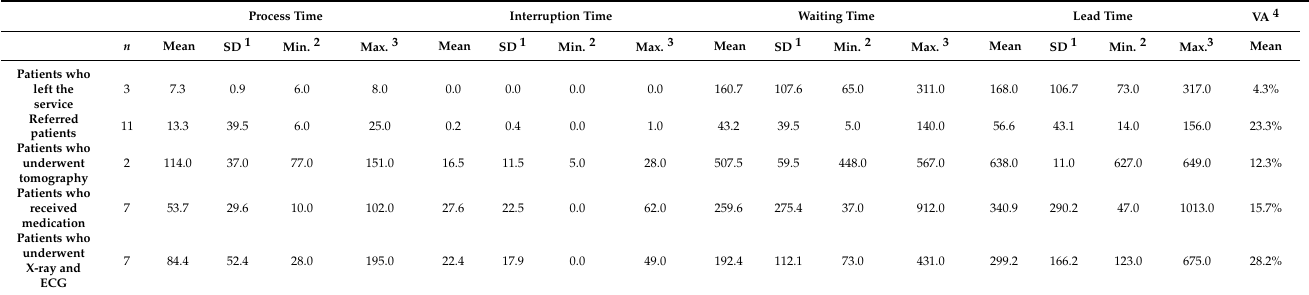
Table 2. Process, interruption, waiting, and lead times and value-added were obtained by the five groups of Value Stream Maps ( n =